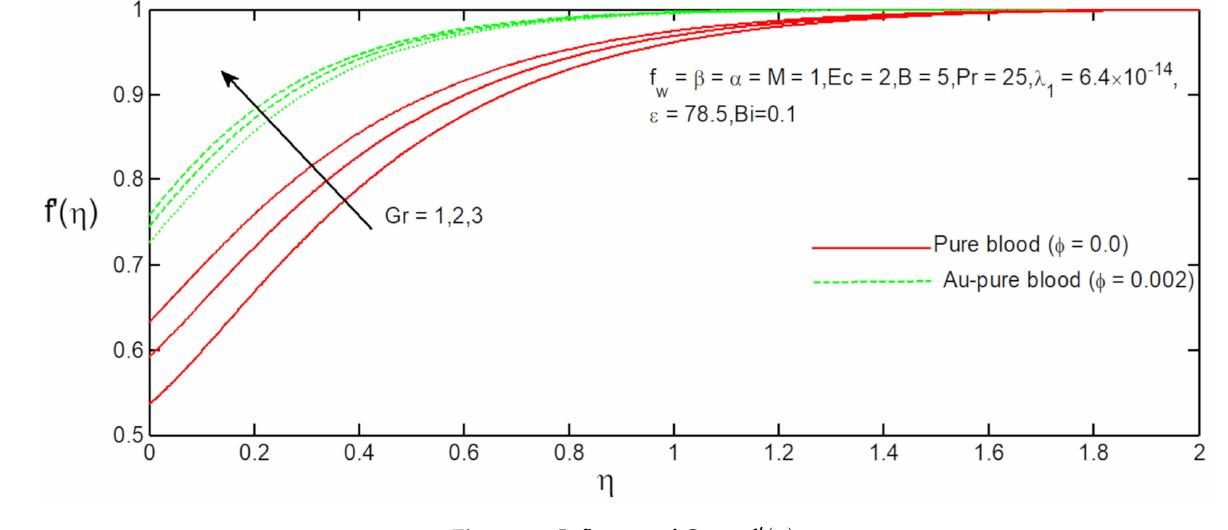
Figure 12. Influence of Gr on f (cid:48) ( η ) .